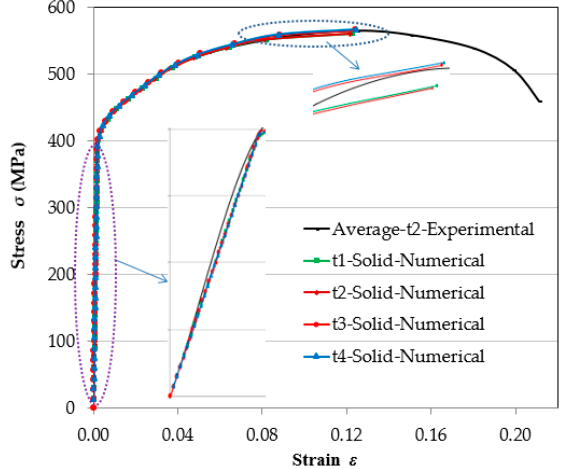
Figure 6. Curves showing the engineering stress-strain gained from both experimental and FE